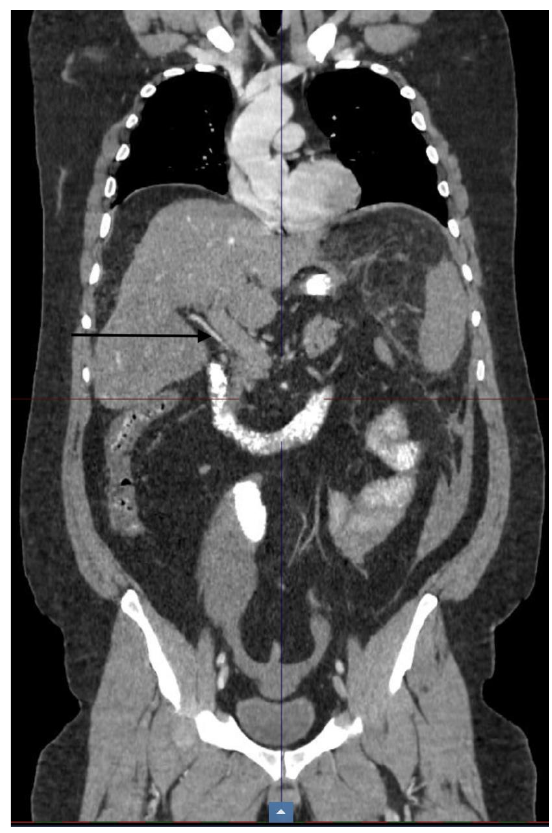
Figure 1. PVT occlusion — CT scan .